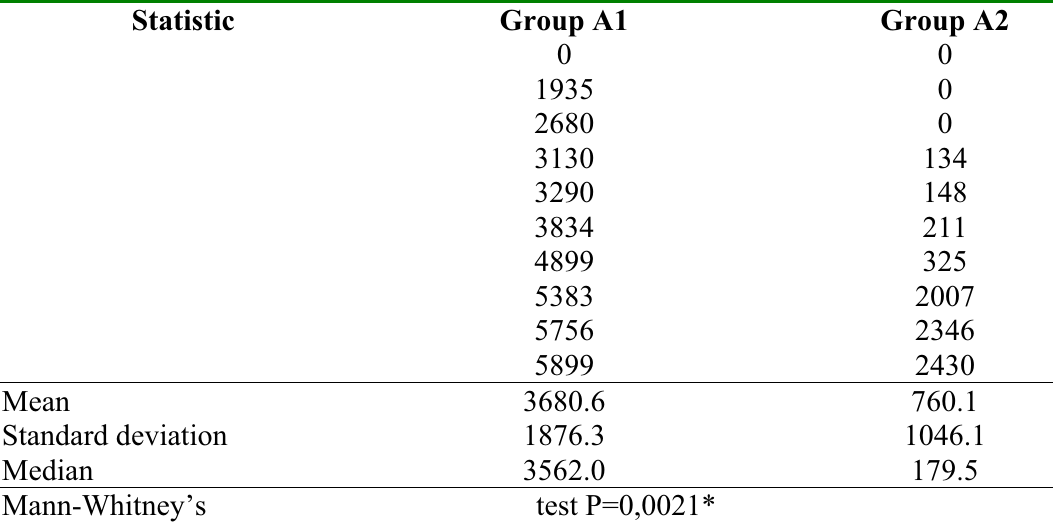
TABLE 1 – Connective tissue length in µm at the osteotomy site of bullae of group A1 (8 weeks of